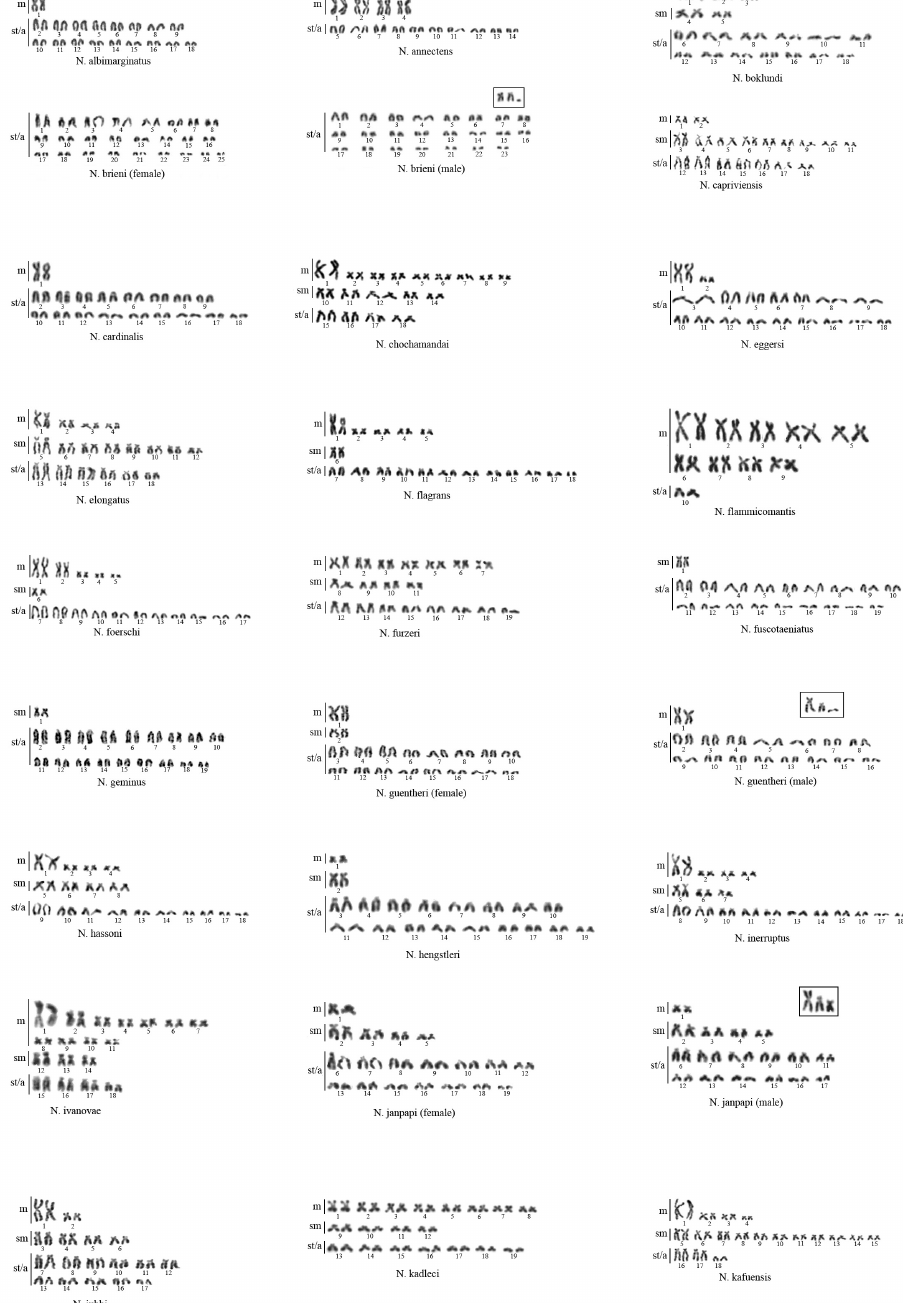
Figure 1. Karyotypes of species Nothobranchius . Scale bar: 10